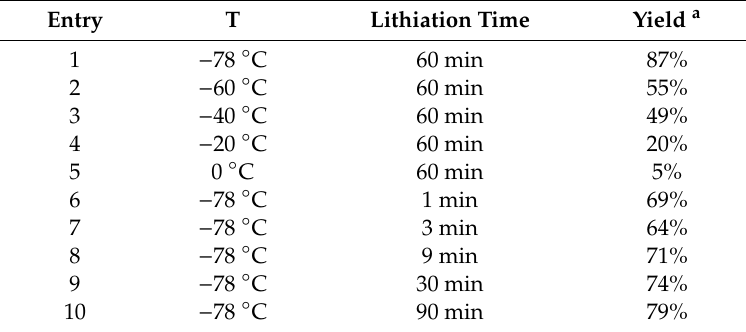
Table 3. Optimization of the tin-lithium exchange and the reaction with 9 . Entry T Lithiation Time Yield